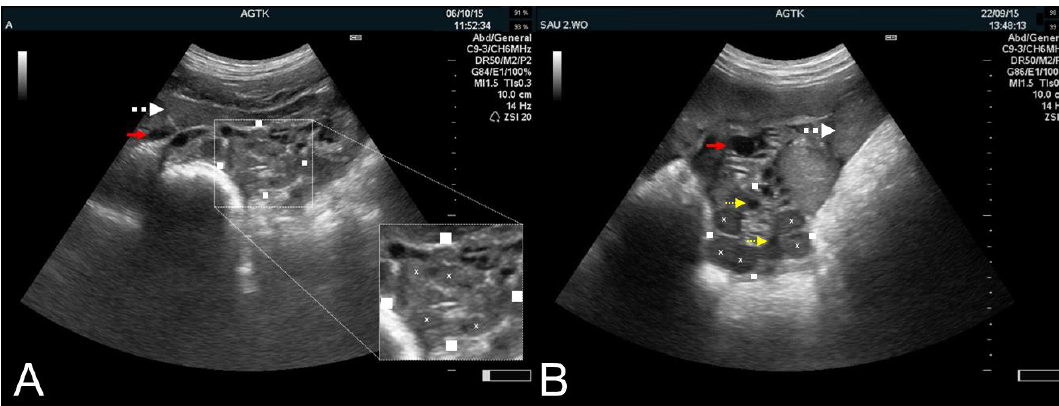
Figure 7. Transabdominal ultrasonographic images of ovaries in sows immediately post-ovulation ( A ) and in diestrus ( B ). Squares mark the transversal and longitudinal dimensions of the ovaries, and “ × ” corpora hemorrhagica ( A inserted picture) or corpora lutea ( B ). Cross-sections of the uterine horns (white, dotted arrows), blood vessels (red arrows), and small follicles (yellow, dotted arrows) are identified. Note that in ( A ), there are no follicles visible. Scale bars on right margins in 0.5 cm steps.